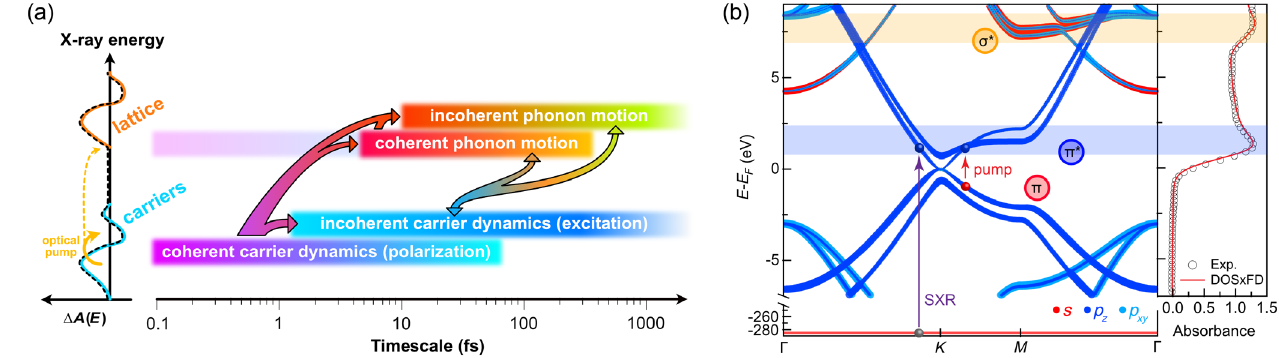
FIG. 1. Carrier and phonon dynamics in graphite. (a) The left-hand panel indicates two areas which are separated in x-ray photon energy, where changesinthedifferentialabsorption occur dueto carrierand lattice motion.Theright-handpanel indicatesthevasttime-overlapping physical effects and their interplay. (b) State-resolved band structure calculated in the local density approximation (LDA) with an ultrasoft Vanderbilt potential and Perdew-Burke-Ernzerhof (PBE) exchange correlation with QUANTUM ESPRESSO [10]. The blue and orange shaded areas indicate π (cid:2) and σ (cid:2) bands originating from p and sp 2 -hybridized states. The arrows show electronic transitions through z SXR (violet) and near-infrared (red) pulses. The measured XANES spectrum (black circles), under 40° incidence angle, is shown on the right. Electronic transitions from the carbon 1 s state (bound by 284.2 eV) to unoccupied states in both the π (cid:2) and the σ (cid:2) bands (1.5 and 7 eV above the Fermi level) dominate the spectrum. The XANES spectrum is in excellent agreement with a numerical model (red) based on the density of states (DOS) and a Fermi-Dirac distribution at room temperature (see SM for further details